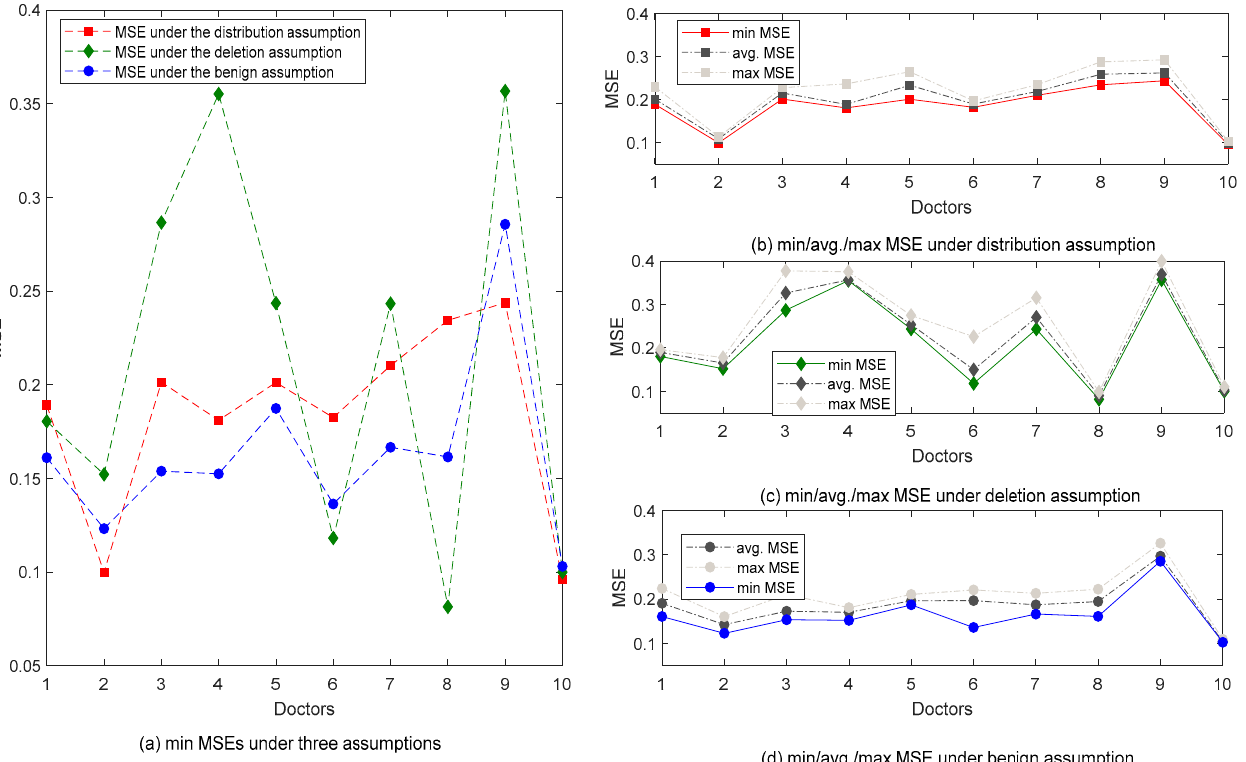
Figure 6. MSE comparison of ten doctors under three